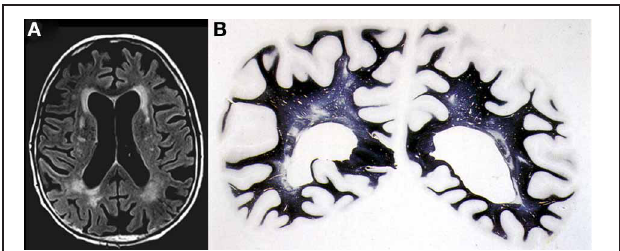
FIGURE 3 | Confluent deep white matter hyperintensities in female aged 78 years with mild cognitive impairment. (A) T2-weighted FLAIR-MRI scan. (B) Multiple small areas of patchy myelin loss and lacunes in both cerebral hemispheres (Kluver-Barrera stain).